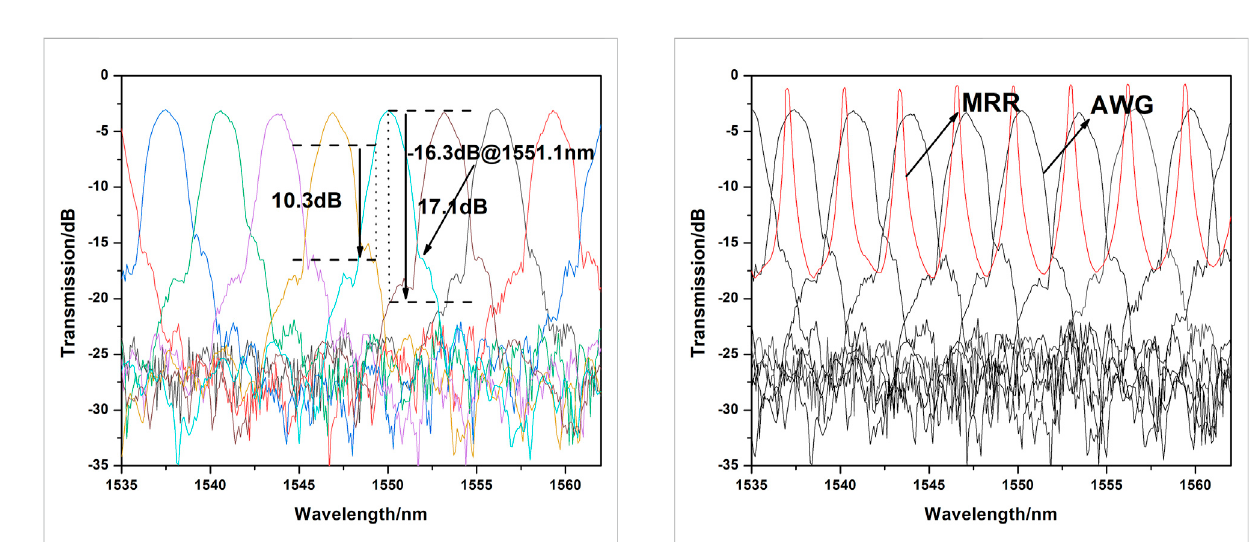
FIGURE 6 Transmission spectra from 8 output channels of conventional AWG.